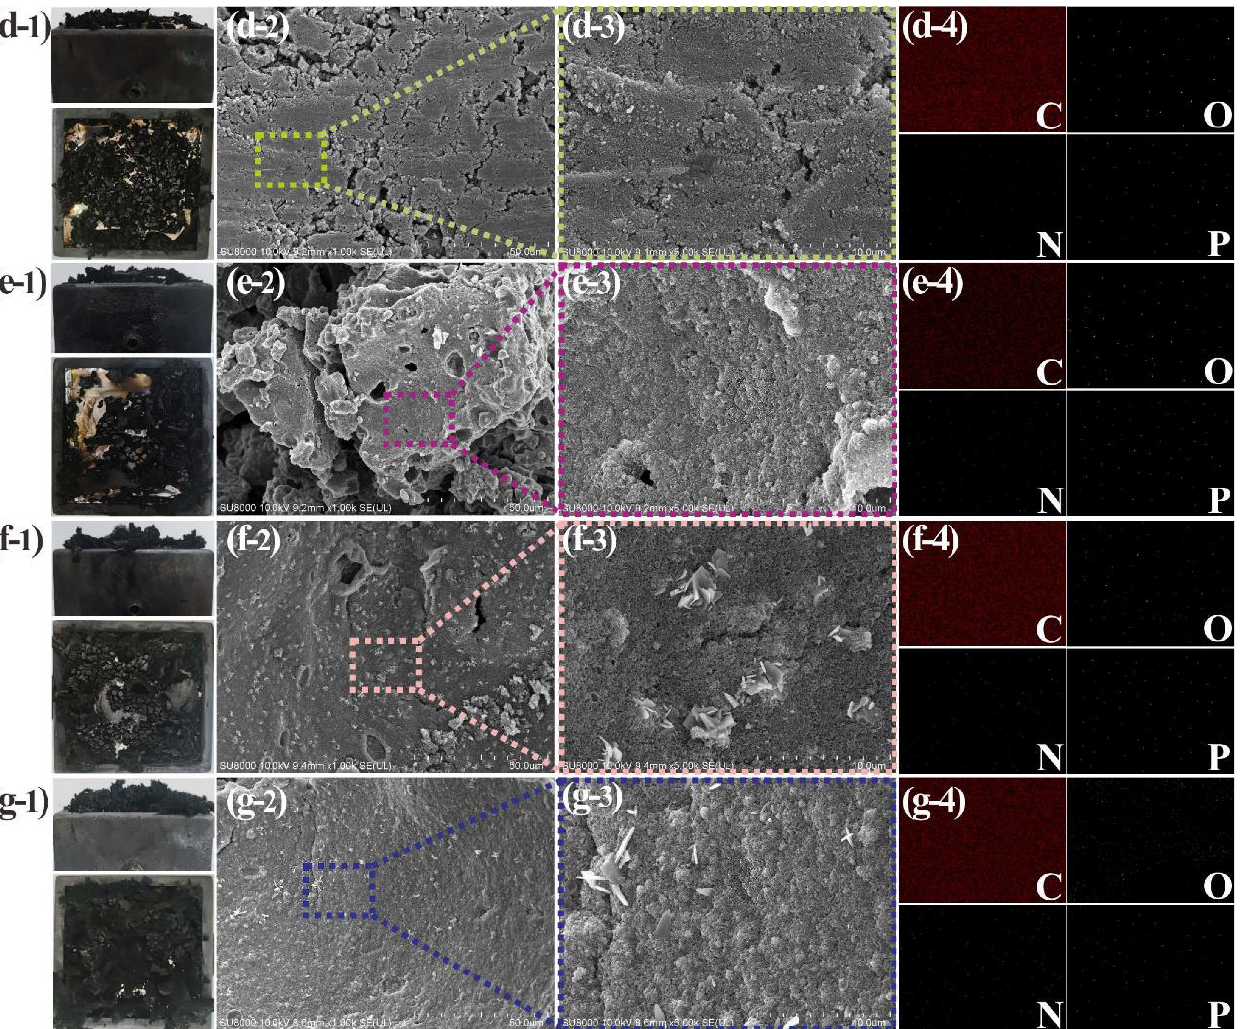
Figure 6. Char residue analysis of NR3 – NR6 composites after CCT: digital photos ( d-1 , e-1 , f-1 , g-1 ); SEM images ( d-2 , e-2 , f-2 , g-2 , d-3 , e-3 , f-3 , g-3 ); EDS-mapping spectrum after 15 min of scanning ( d-4 , e-4 , f-4 , g-4 ).